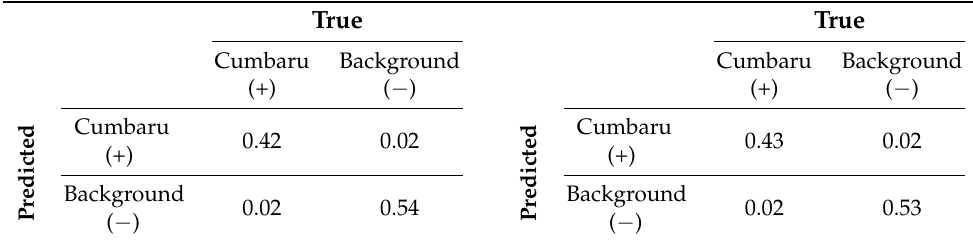
Table A1. Confusion matrix for the U-Net without CRF (left) and with CRF (right). The values are normalized by the total of pixels.